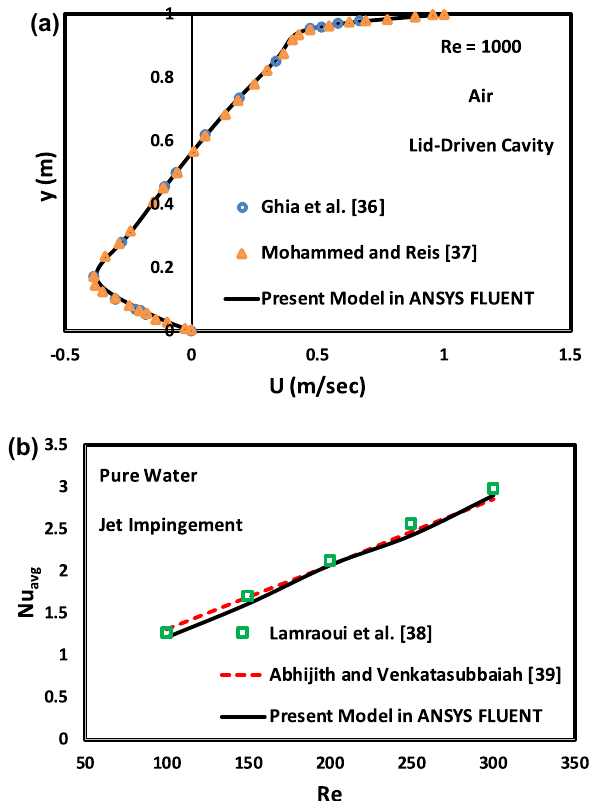
Fig. 3 Velocity and heat transfer validation: a Horizontal velocity versus vertical height along the center line of the lid-driven cavity, and b Average Nusselt number at different Re for jet impingement